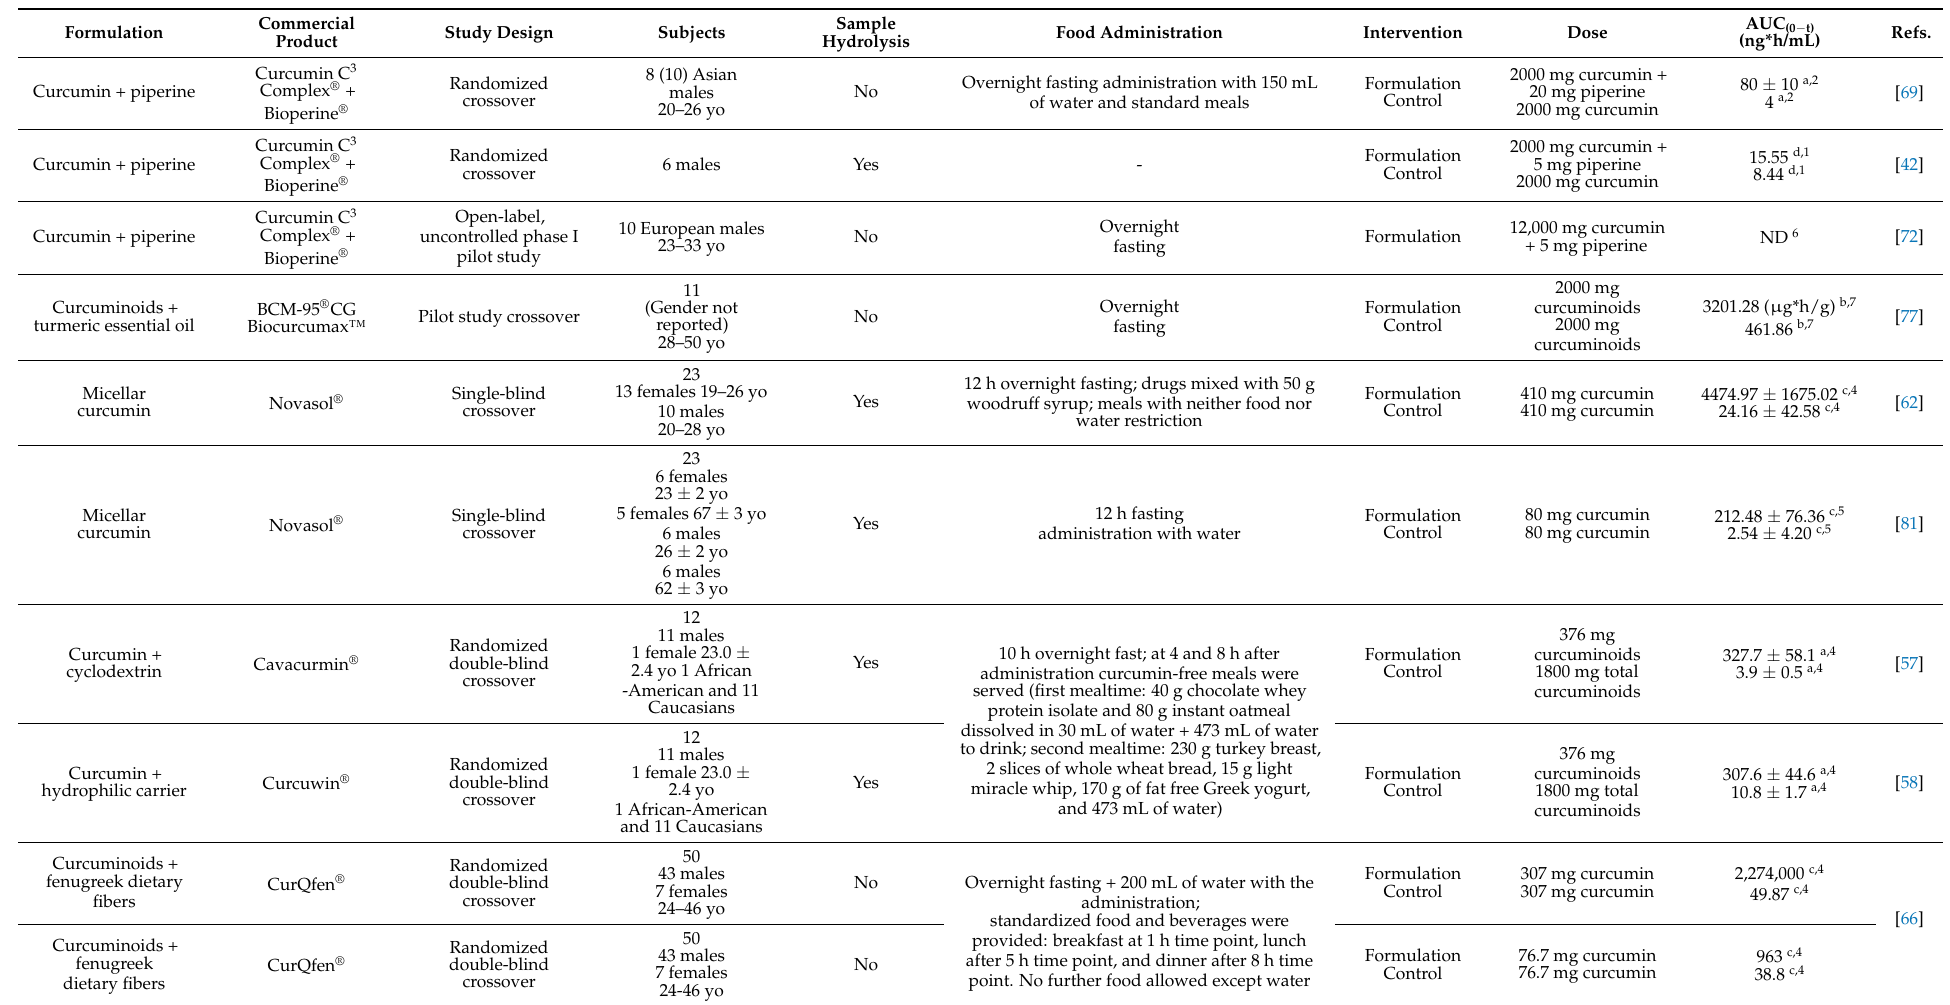
Table 1. The pharmacokinetic profile of curcumin considering various commercially available, curcumin-based